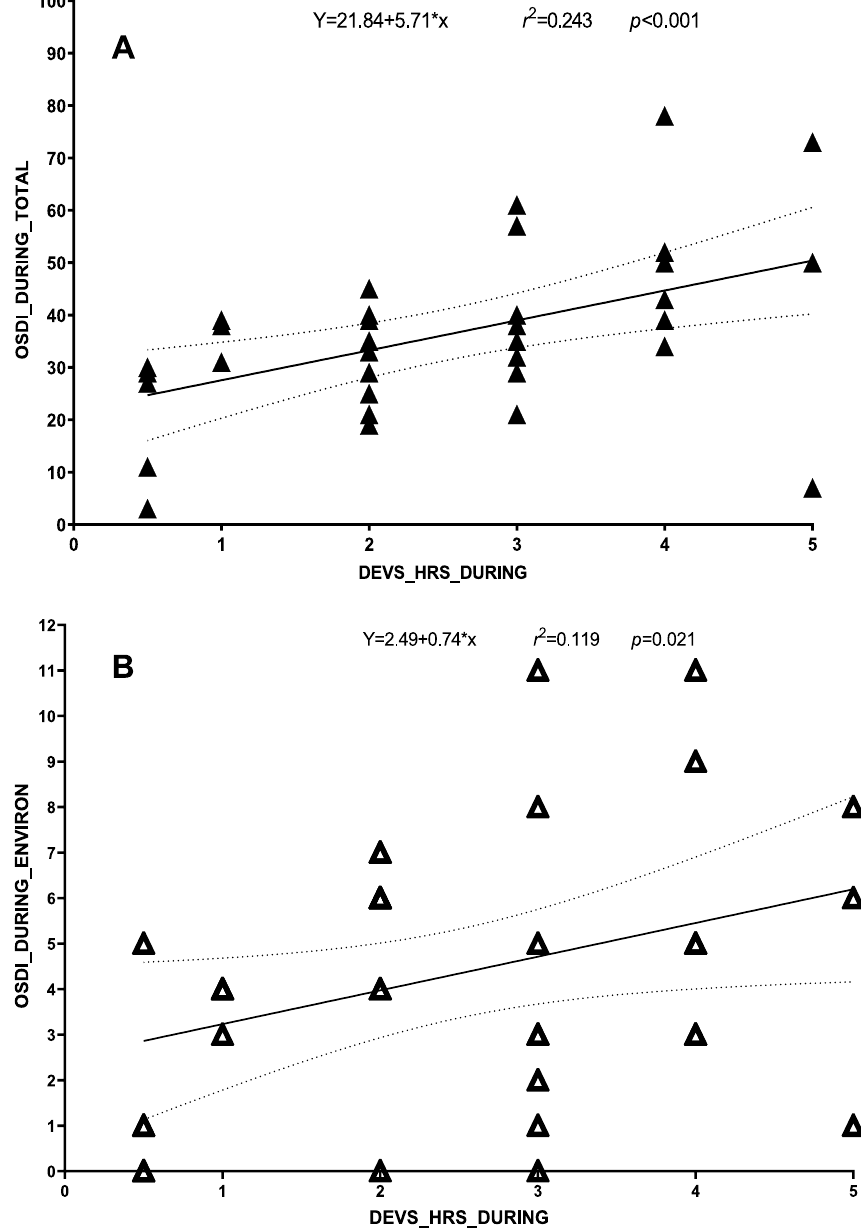
Figure 1. Regression equations: these scatterplots represent the relationships between daily number of hours spent on viewing electronic devices and OSDI questionnaire TOTAL (A) and OSDI questionnaire ENVIRON (B) scores in the “during” period. Dotted lines representing the 95% Confidence Intervals.